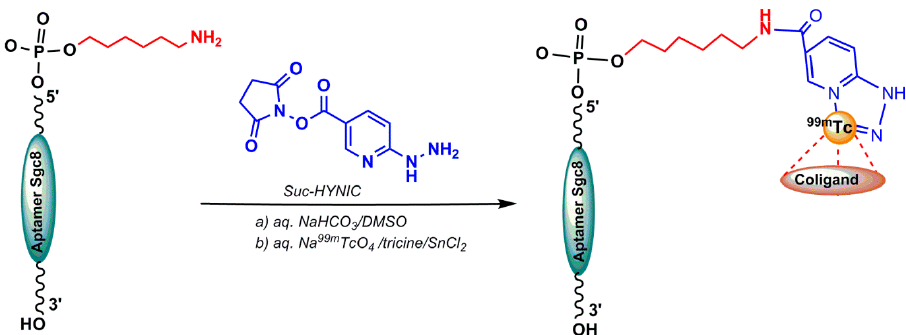
Figure 6. Conjugation of the 6 ‐ hydrazinonicotinamide succinimidyl ester (Suc − HYNIC) to an amine ‐ derivatized aptamer, and radiolabeling.